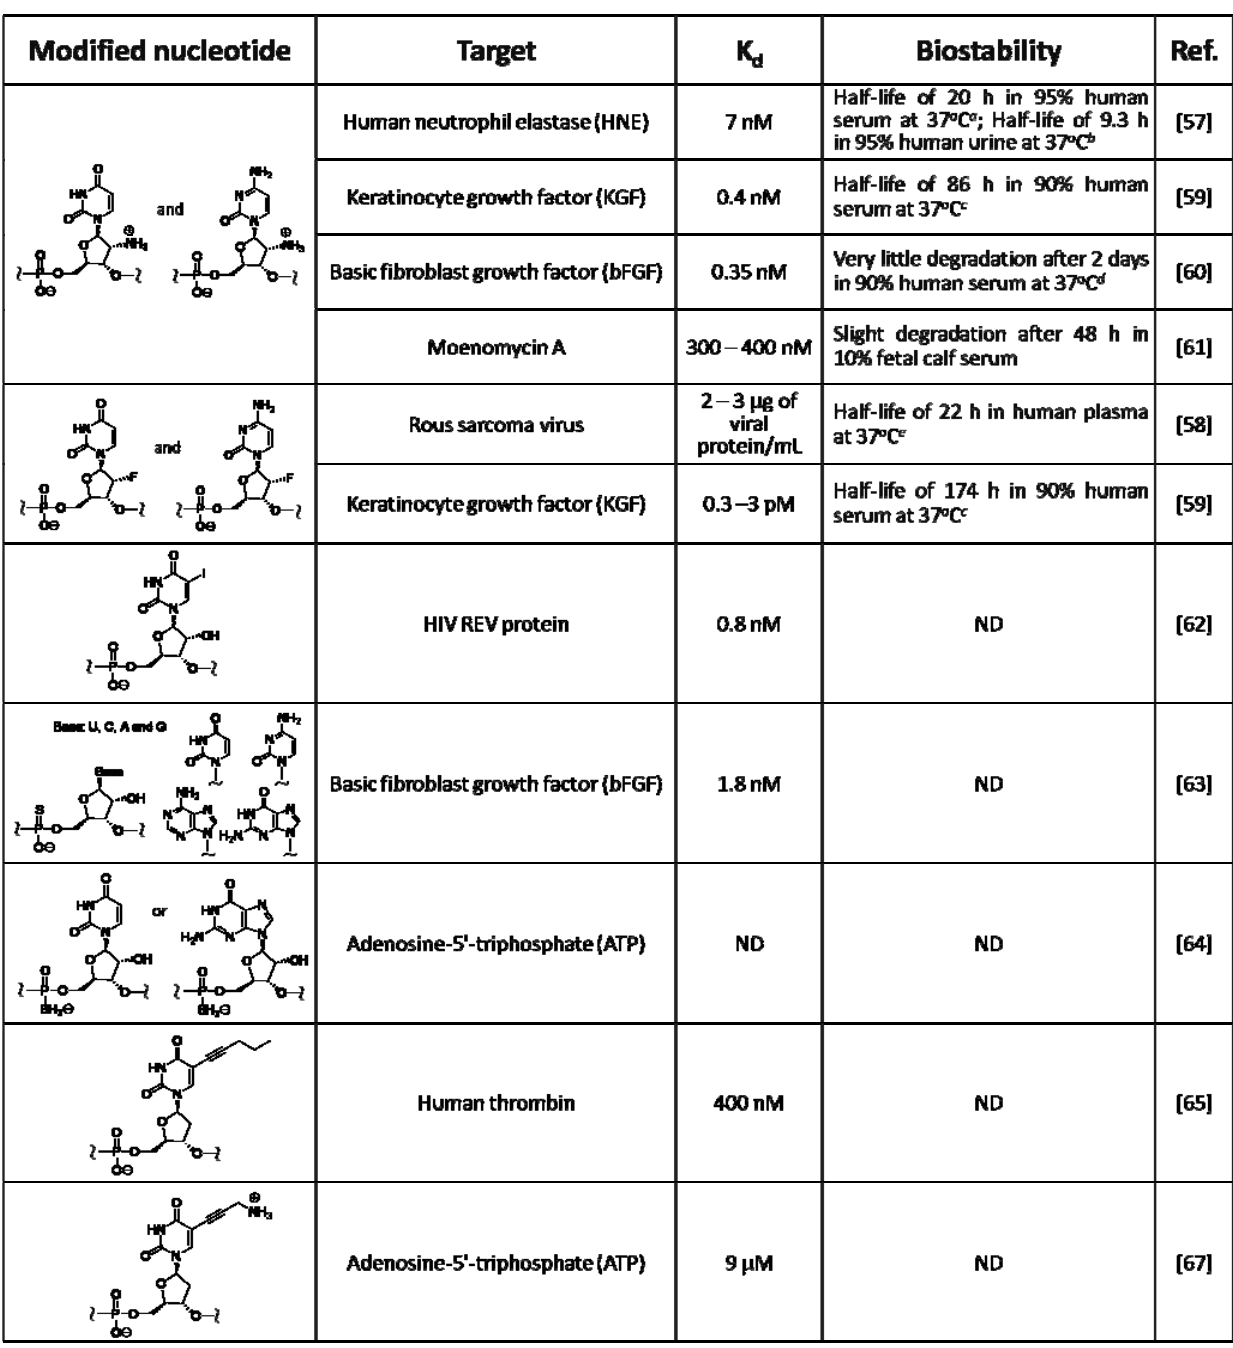
Table 2. Examples of chemically modified RNA/DNA